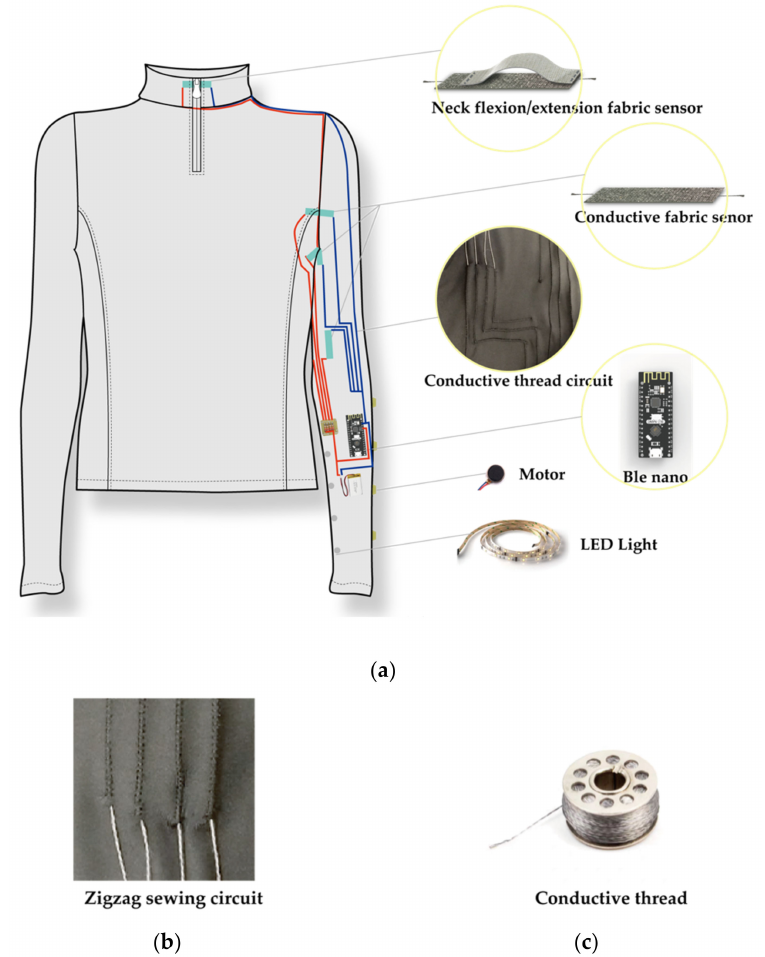
Figure 3. ( a ) Illustrative image of our E-motionWear t-shirt with details of the components; ( b ) Zigzag sewing to protect the conductive thread circuit; and ( c ) Stainless conductive thread employed in our prototype.